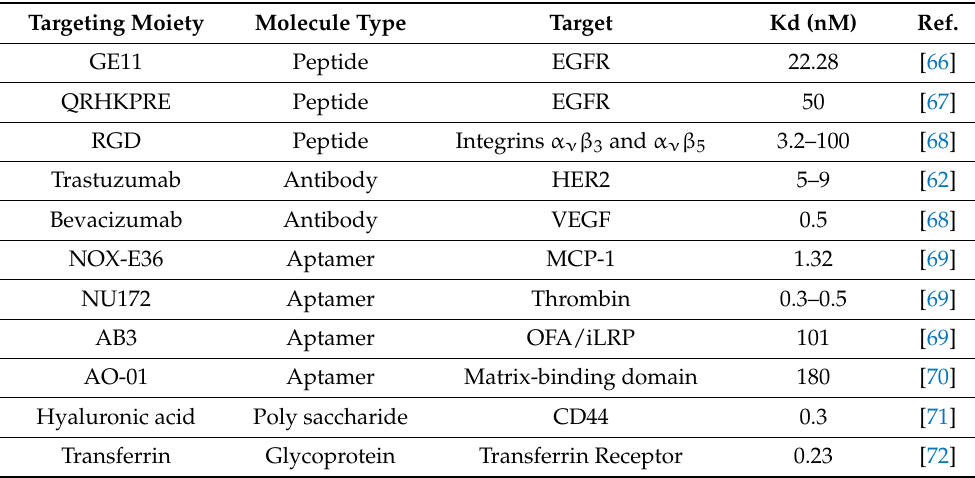
Table 1. Representative active targeting moieties and their respective dissociation constant values. The list includes peptides, antibodies, and aptamers used for active